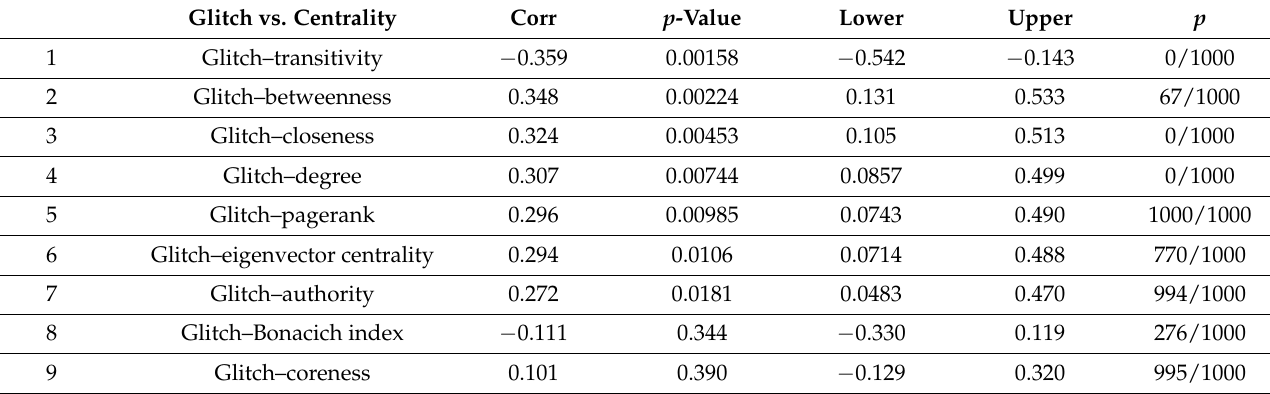
Table A2. Pearson correlations.